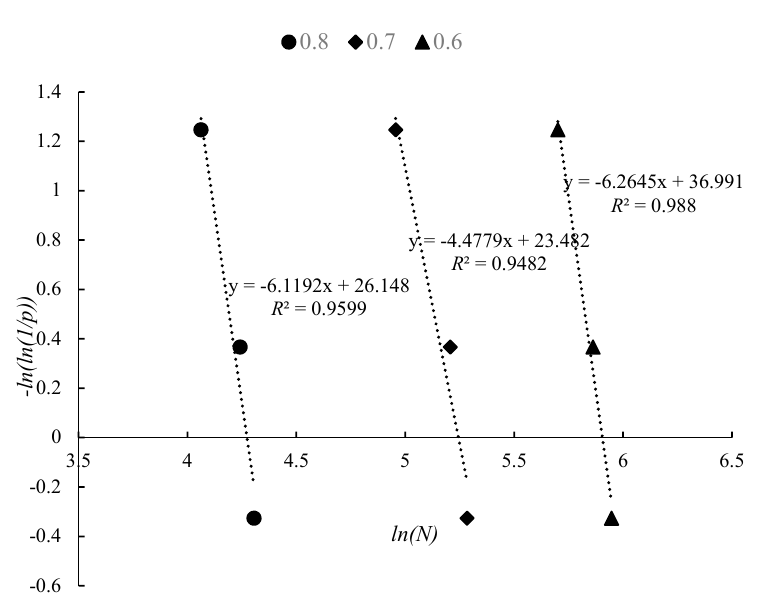
Figure 10. Fitting results of the p - N equation for different stress levels.